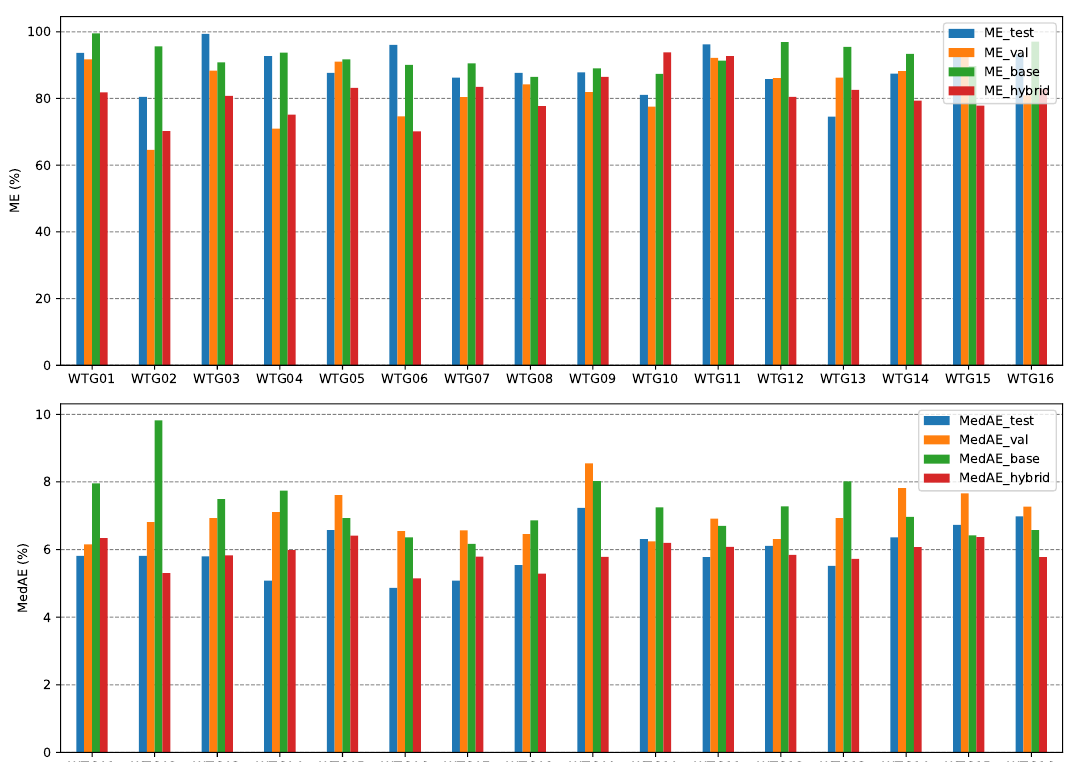
Figure 10. Normalized Median Absolute Error and Maximum Error for model predictions at all wind turbines. It is again clear that the hybrid model outperforms the